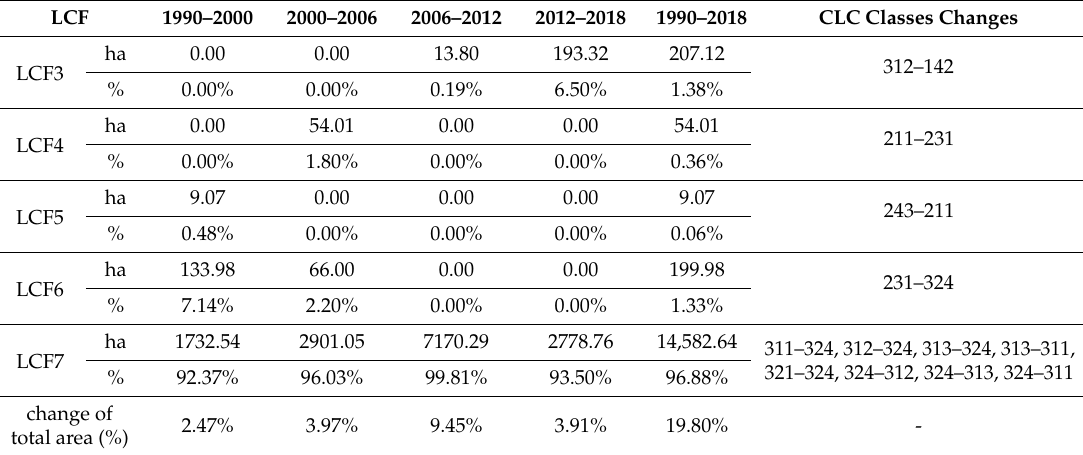
Table 4. Land cover flows (LCF) in the Low Tatras National Park between 1990 and